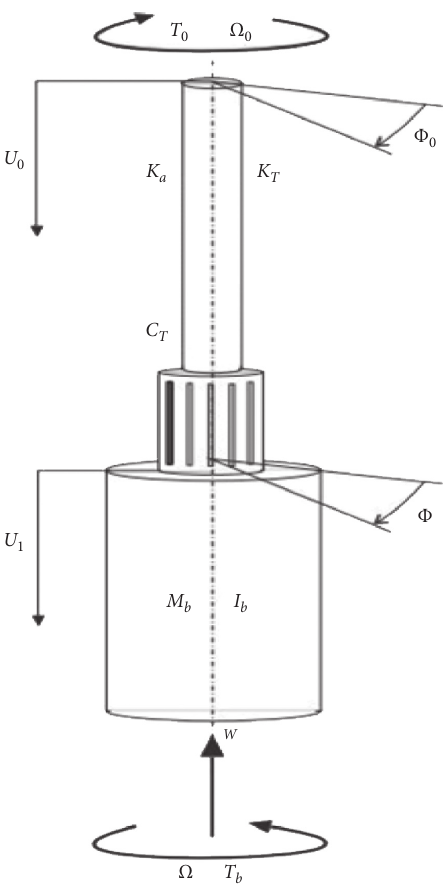
Figure 1: Schematic diagram of the 2 DOFs model of the drilling string. Table 1: Dimensions of the axial dynamics of the drillstring system.